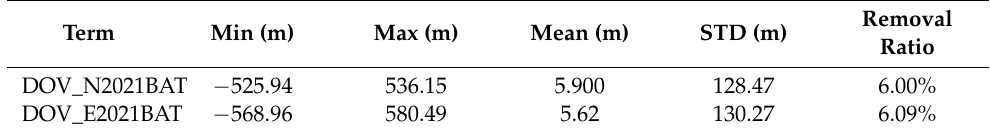
Table 1. Precision statistics of bathymetry inversion results by